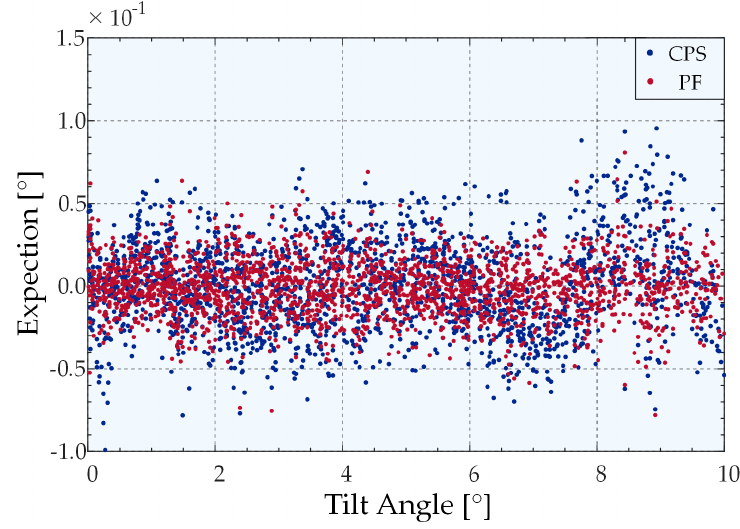
Figure 16. Angle prediction errors for different fitting strategies.